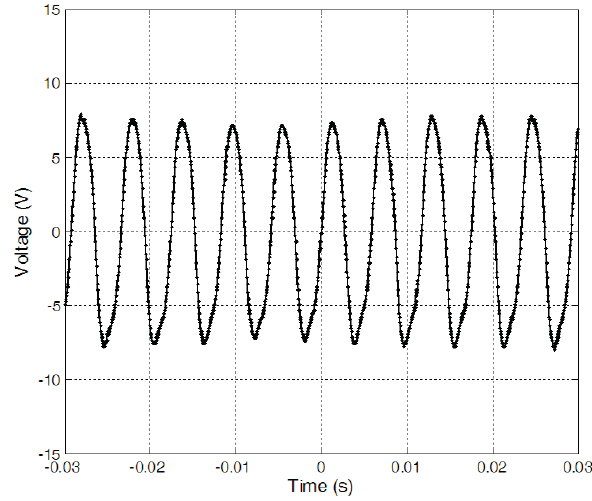
Figure 6. Time history of voltage on a 20 k Ω resistor with wind speed of 11.2